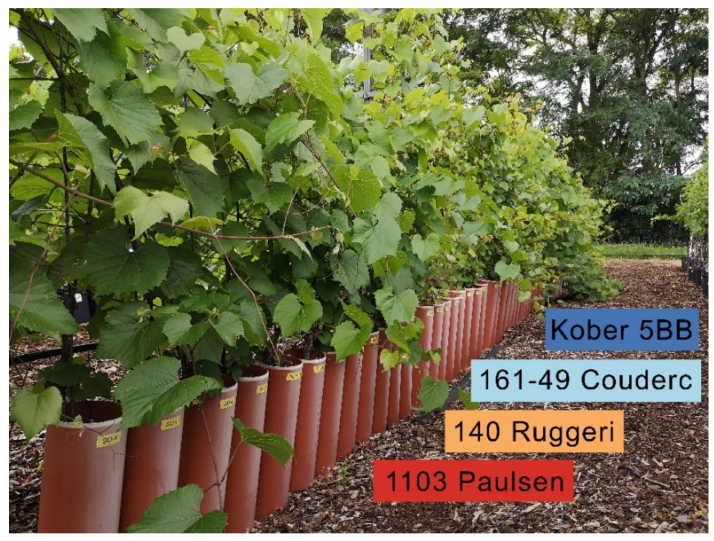
Figure 1. Experimental vineyard. The grapevine rootstocks are planted in cylindrical tubes with a diameter of 15 cm and a height of 120